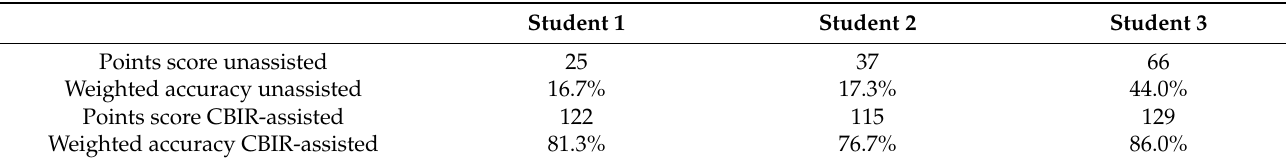
Table 3. Results of the students’ weighted accuracy. Point scores are out of a maximum of 150. All students’ weighted accuracies in the unassisted test runs proved to be significantly different ( p < 0.01) from the CBIR-assisted test